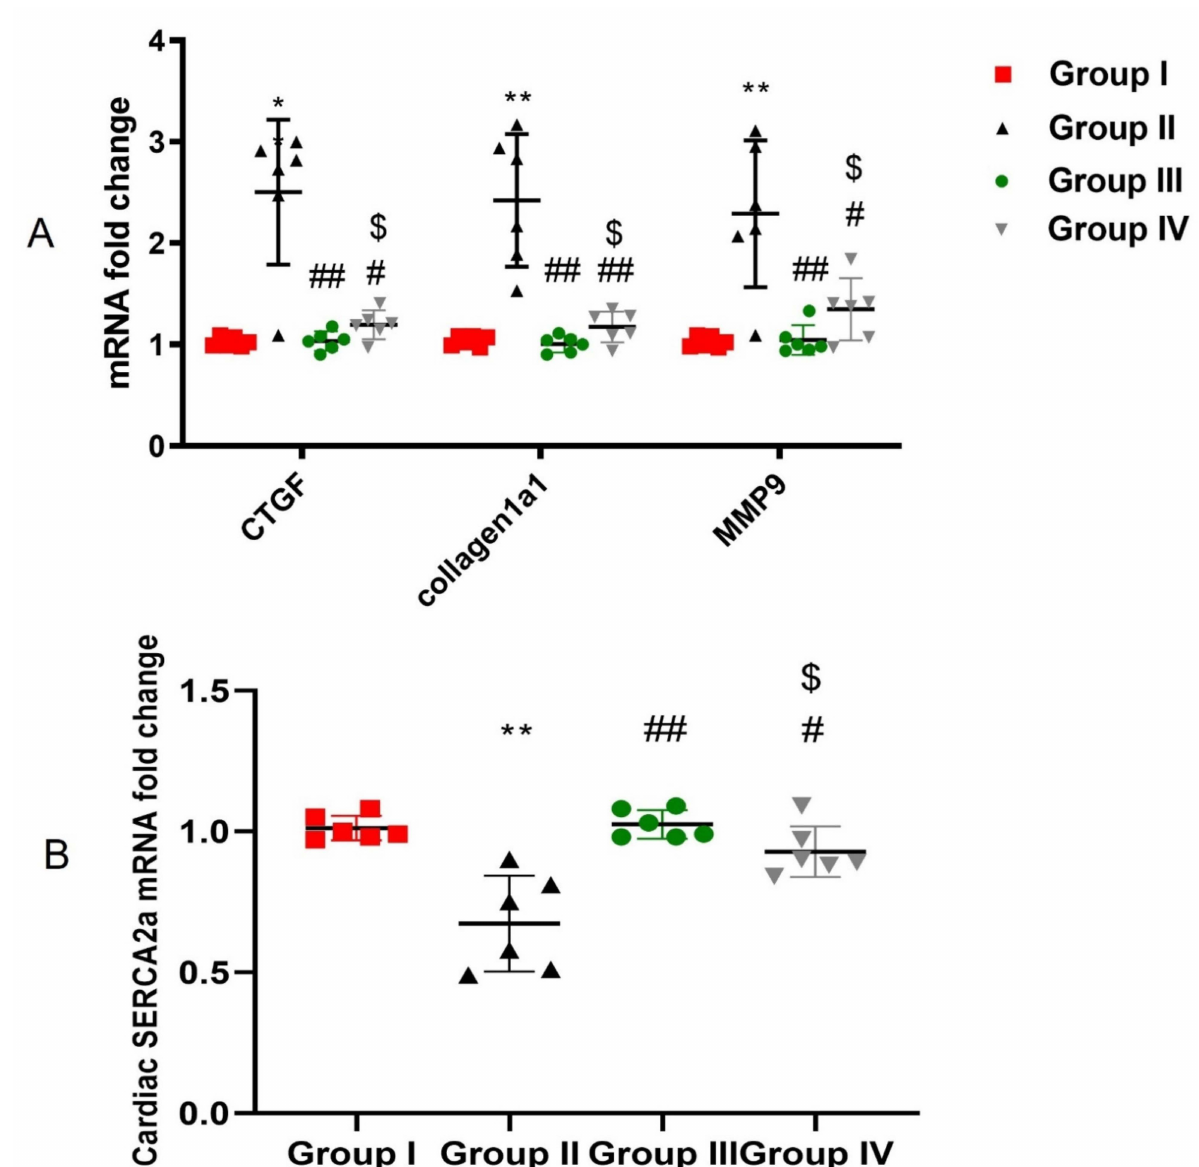
Figure 6. Effect of ADMSCs-derived exosomes on DOX/Trz-induced cardiac fibrosis and Ca 2+ homeostasis: ( A ) mRNA levels of cardiac connective tissue growth factor (CTGF), collagen1a1, and Matrix metallopeptidase 9 (MMP9); and ( B ) mRNA levels of cardiac SERCA2a. Data are expressed as median (maximum, minimum). *, significant compared to Group I at p < 0.05; **, significant compared to Group I at p < 0.01; #, significant compared to Group II at p < 0.05; ##, significant compared to Group II at p < 0.01; $, significant compared to Group III at p < 0.05; n =